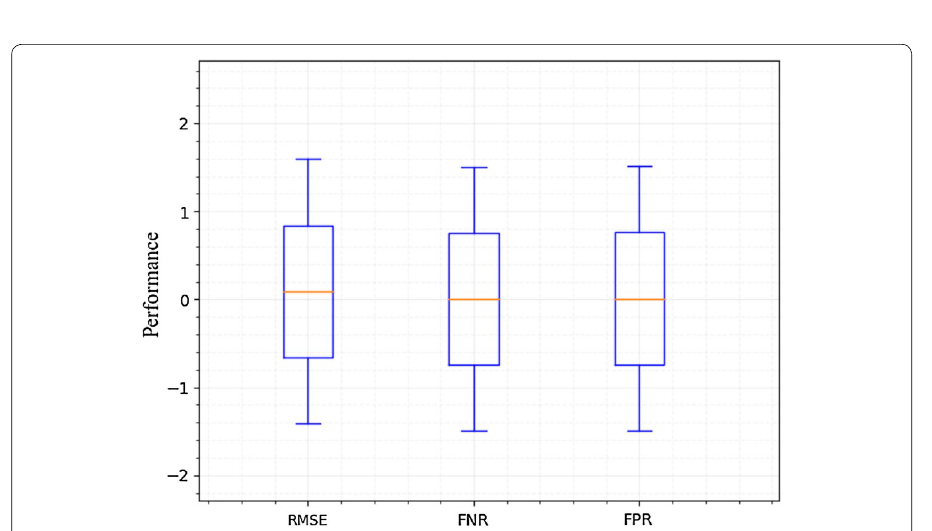
Fig. 13 Proposed RMSE, FNR and